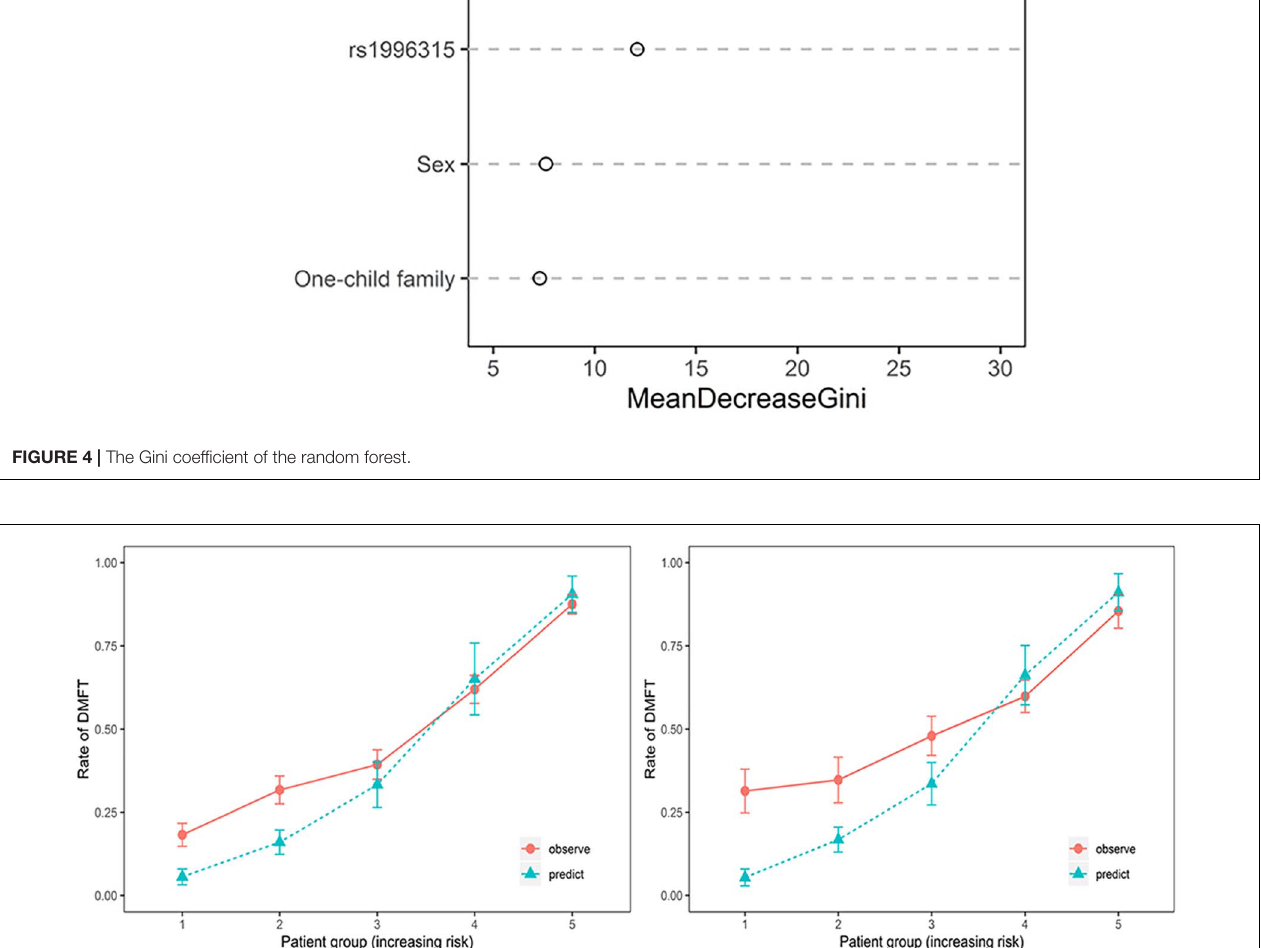
Frontiers in Genetics |